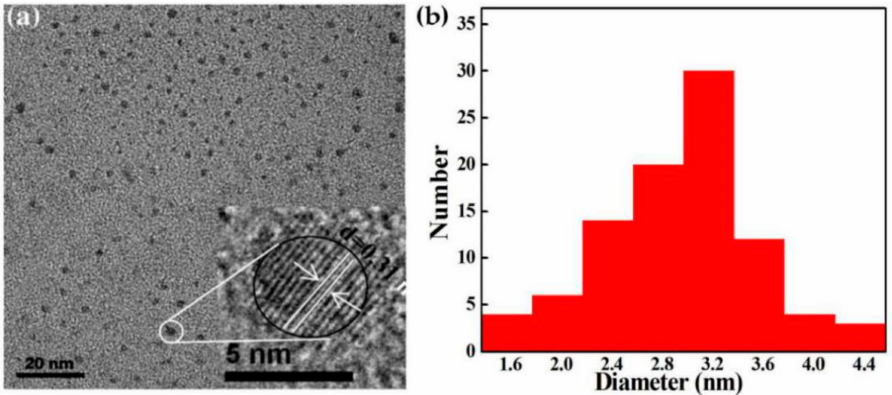
Figure 2. ( a ) TEM image and ( b ) size-distribution of